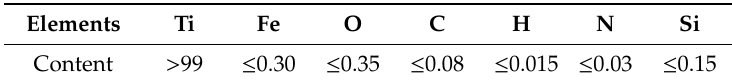
Table 1. Nominal chemical composition of commercial TA2 (wt.%).